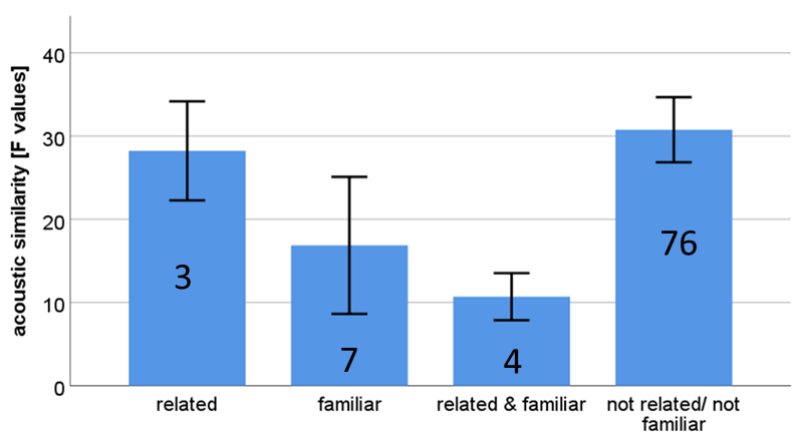
Figure 2. Dyadic acoustic similarity between related, familiar, related and familiar, and dyads that are neither related nor familiar. Acoustic similarity is expressed in F-values (i.e., low F-values refer to high similarity, and high F-values to low similarity). The figure shows the mean ± SEM. Numbers in bars give the number of dyads per